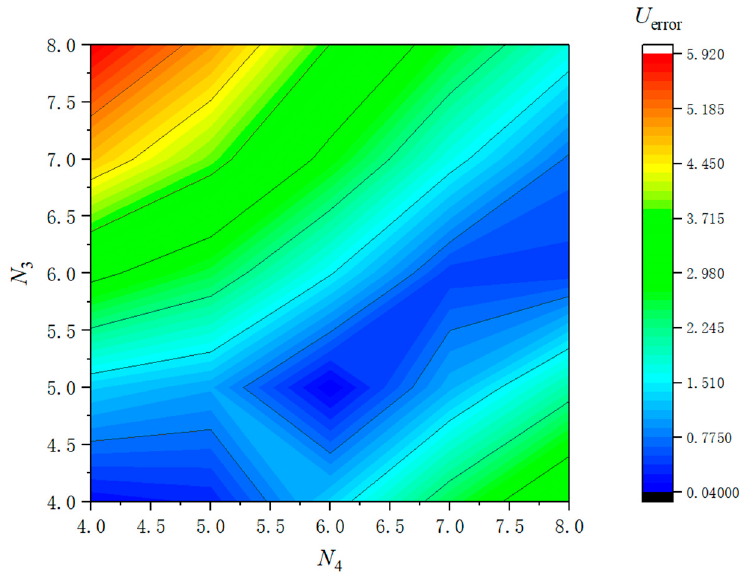
Figure 8. The relationships among N 3 , N 4 , and U error.